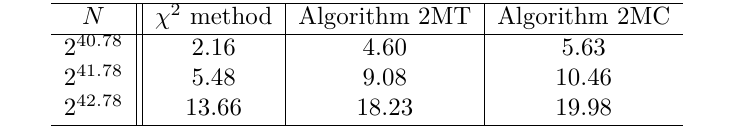
Table 3: Comparison of Advantages for the χ 2 method, Algorithm 2MT, and